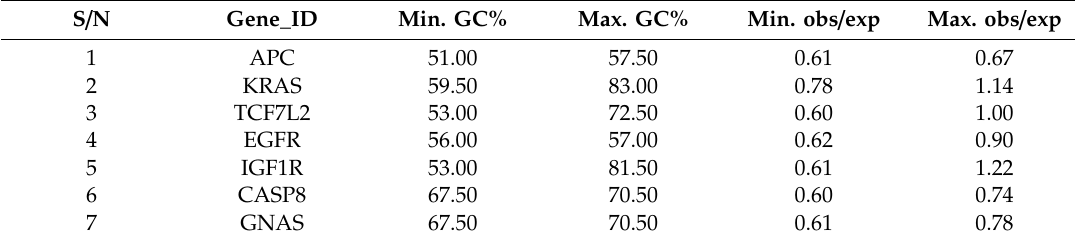
Table 2. Result of the CpG island assessed by sequence manipulator